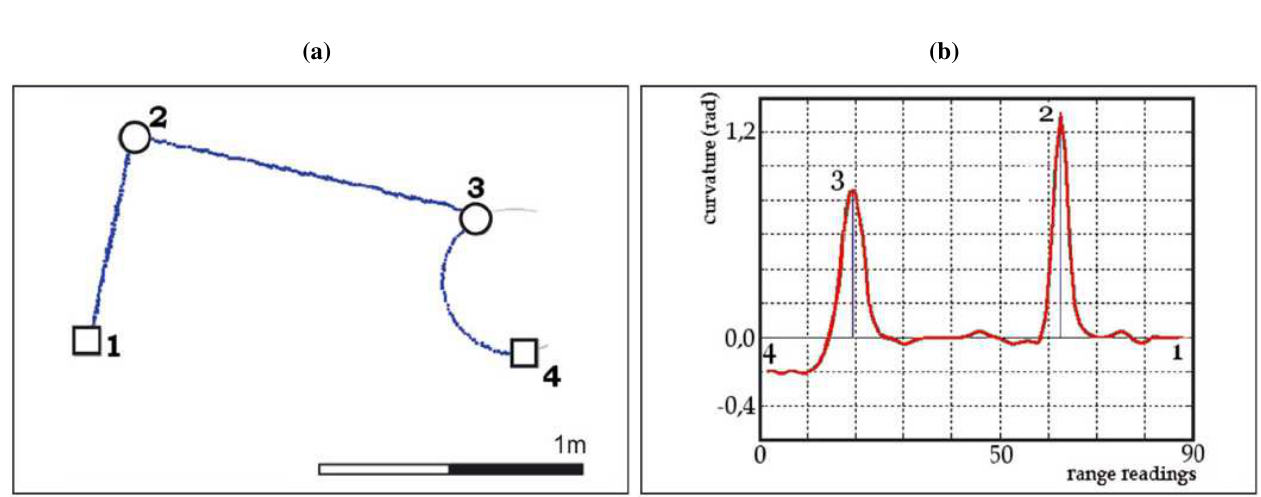
(a) Segment of a single laser scan ( (cid:164) -breakpoints, o-corners). (b) Curvature function associated to